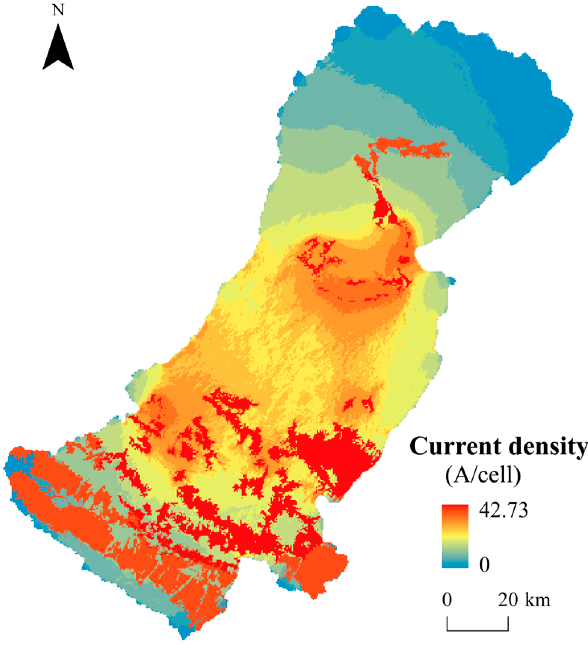
Figure 7. The current map of study area.